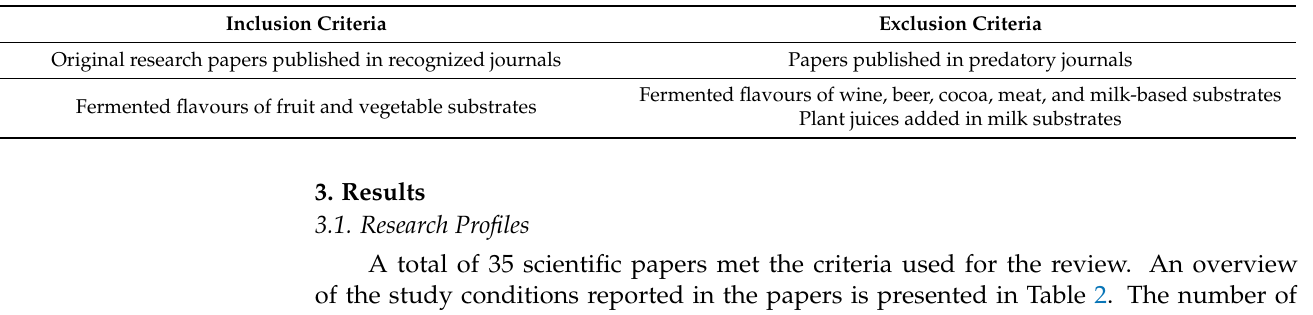
Table 1. Inclusion and exclusion criteria for screening papers.